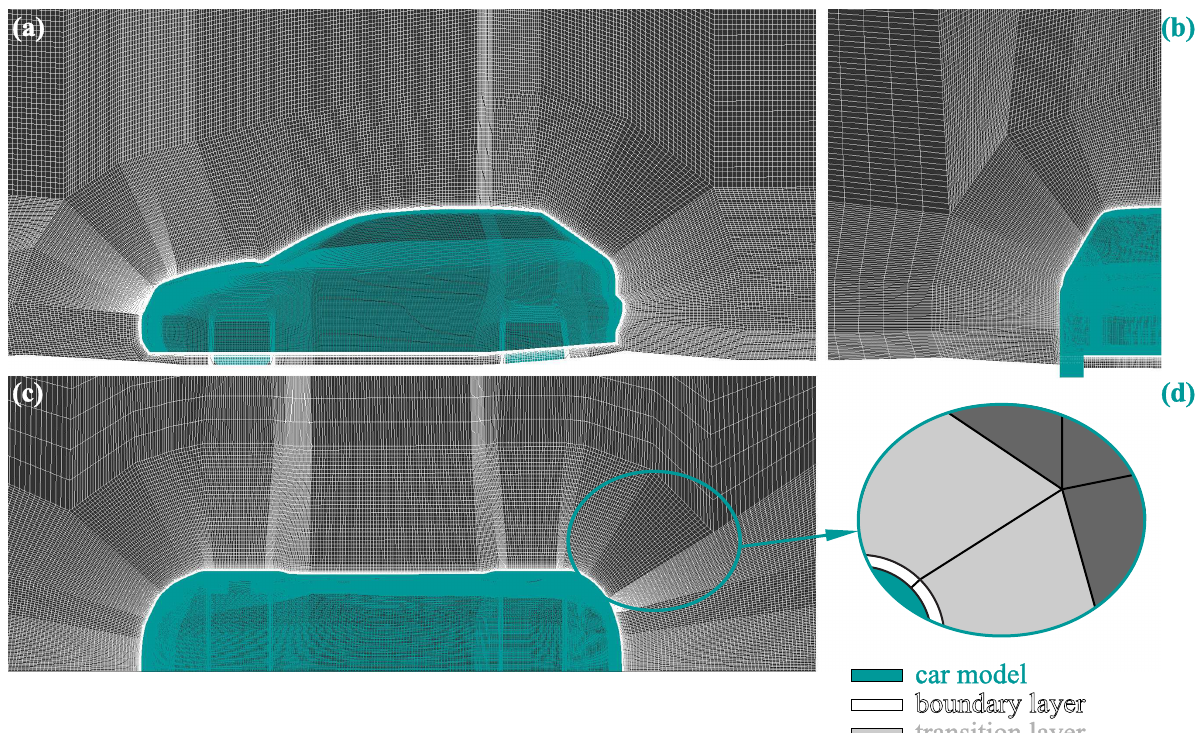
Figure 4. Discretization of single car block—3D model. View from: ( a ) side, ( b ) front, and ( c ) top of the tunnel. ( d ) Schematic of grid layers near the